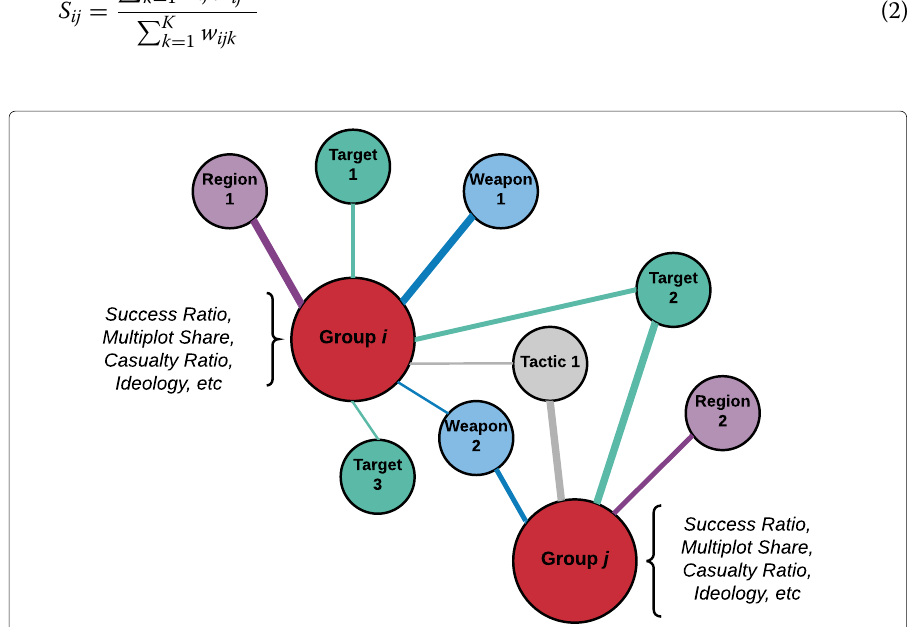
Fig. 1 Example of a Multi-partite Network. The graphic illustrations shows a multi-partite network that includes two groups i and